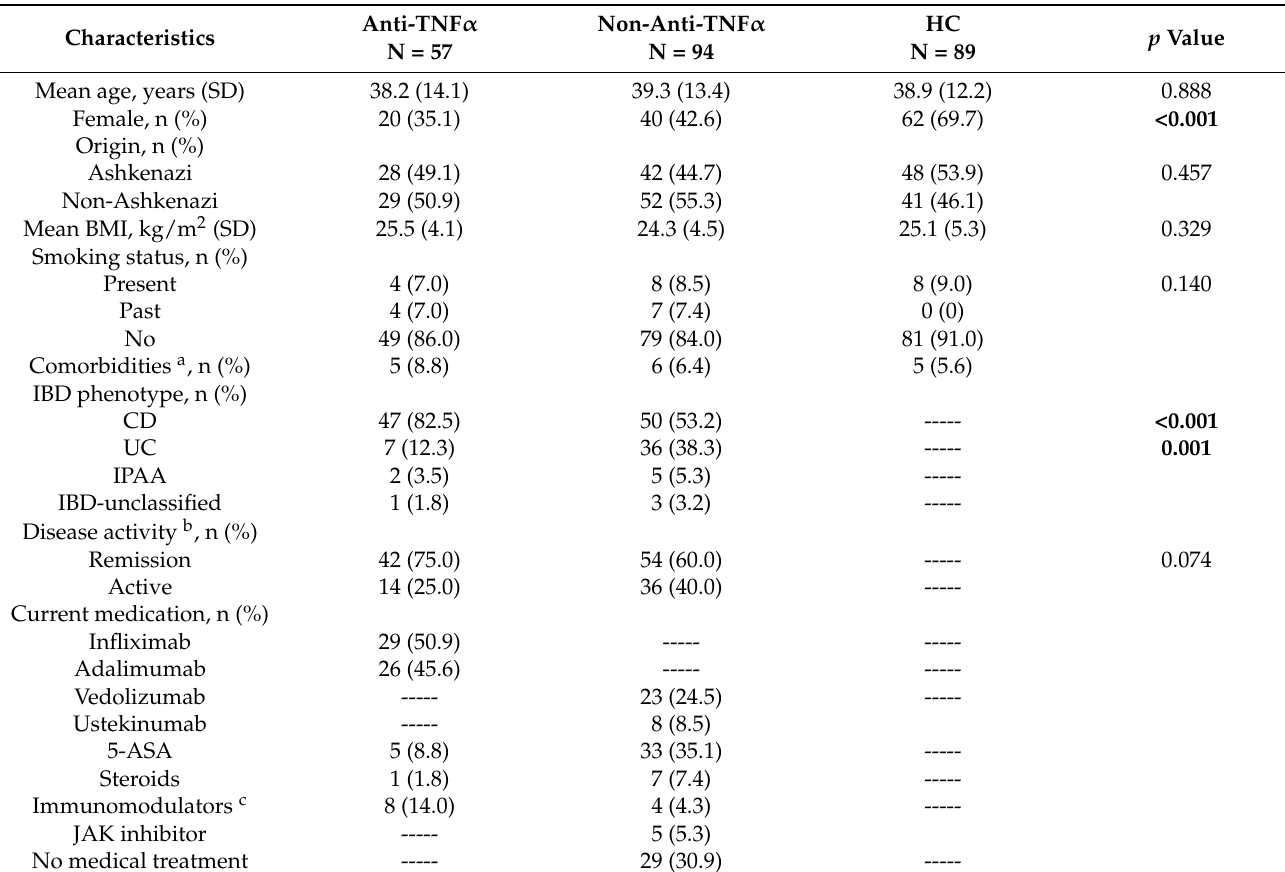
Table 1. Demographic characteristics of